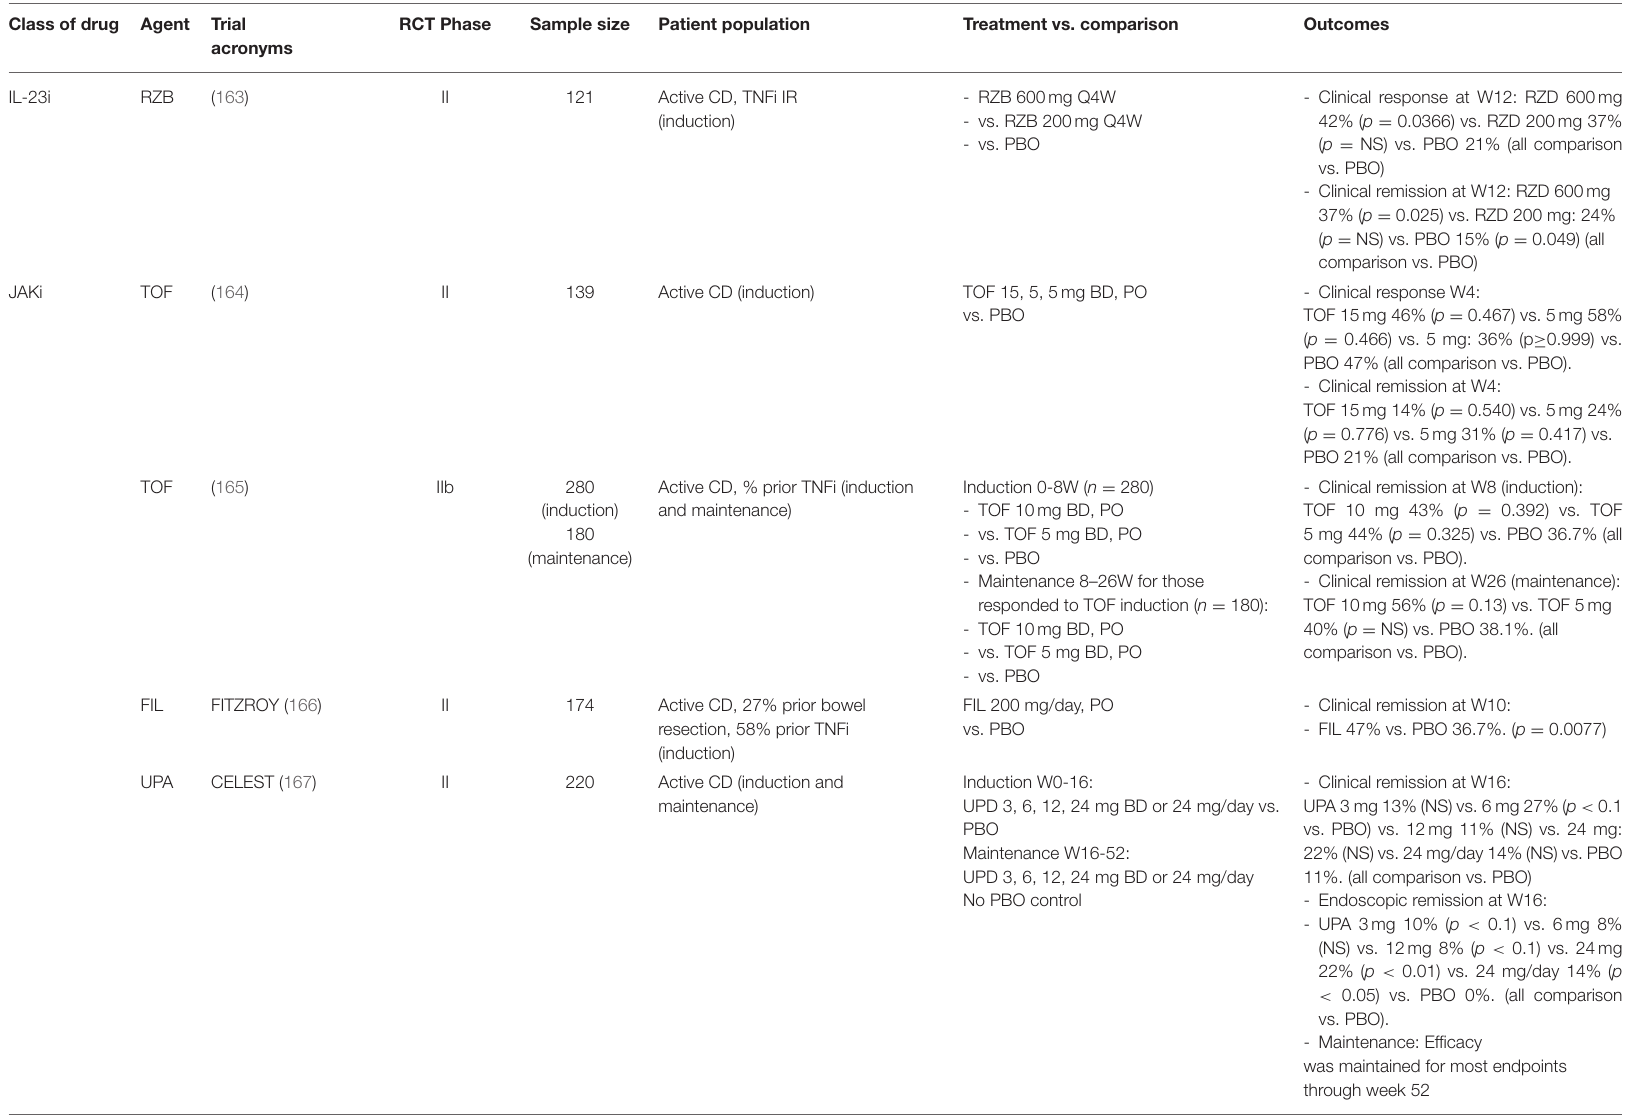
Class of drug Agent Trial